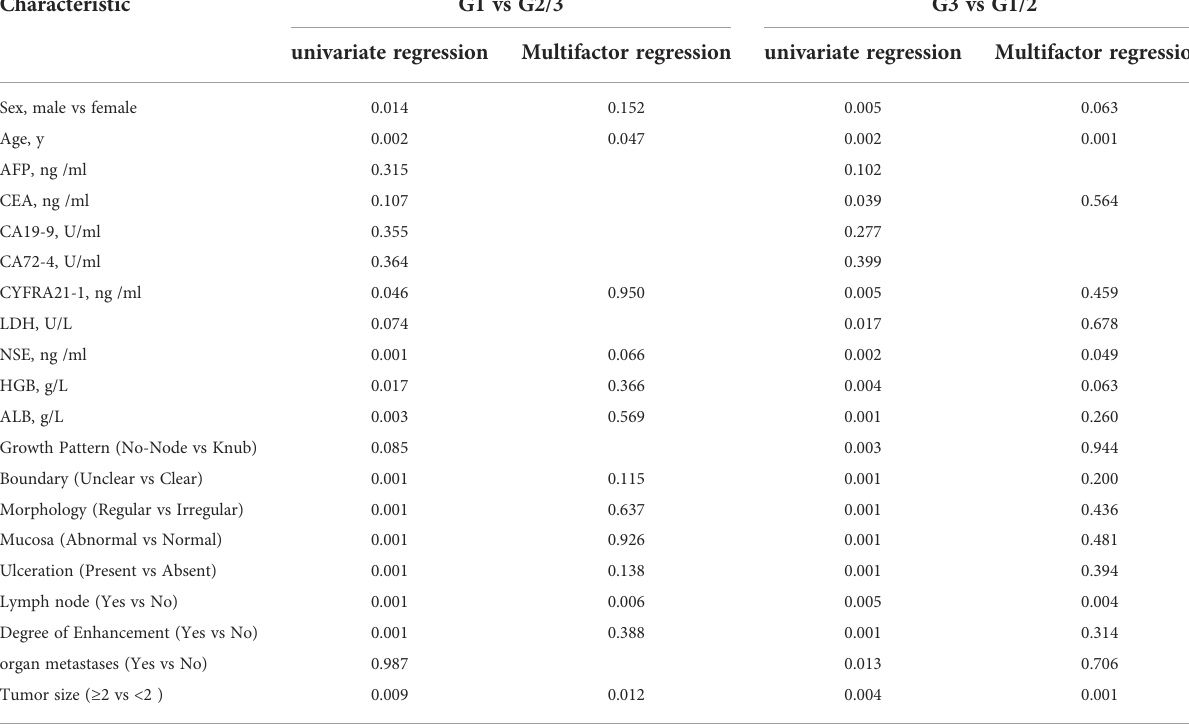
TABLE 2 Univariate and Multifactor Logistic Regression Model for Predicting in 147 Patients.